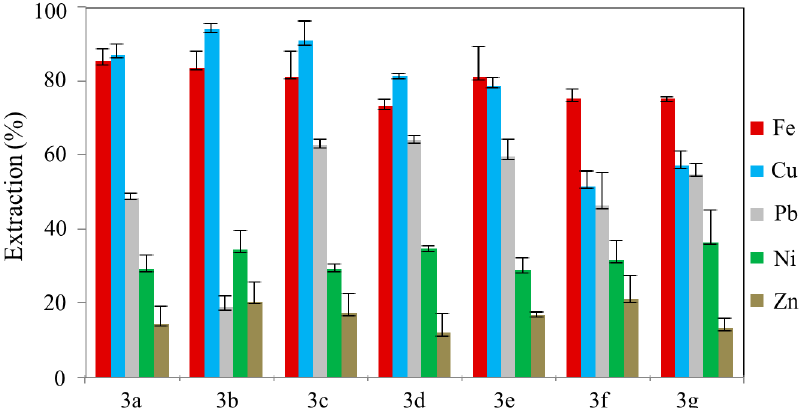
Figure 3. Extraction efficiencies of metal cations by the triazolic piperazine polymers 3a – g (by polymer, in triplicate).